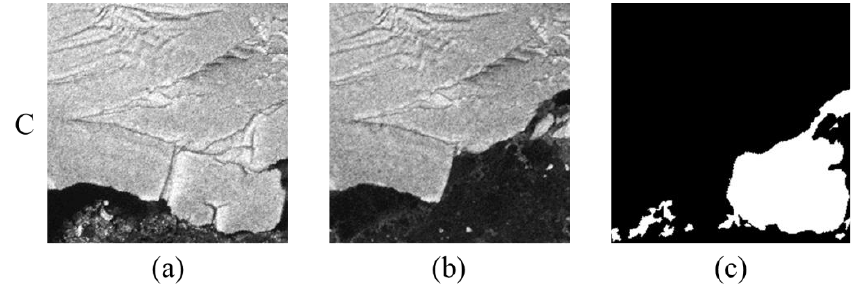
Figure 7. Sulzberger dataset. ( a ) Image acquired on 11 March 2011. ( b ) Image acquired on 16 March 2011. ( c ) Ground-truth map.